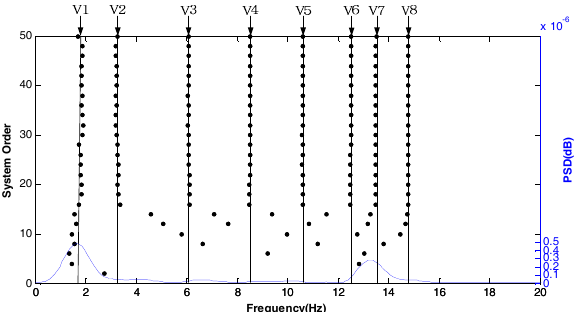
Figure 6. Stabilization diagram in the Y direction of test point 1 under normal conditions.